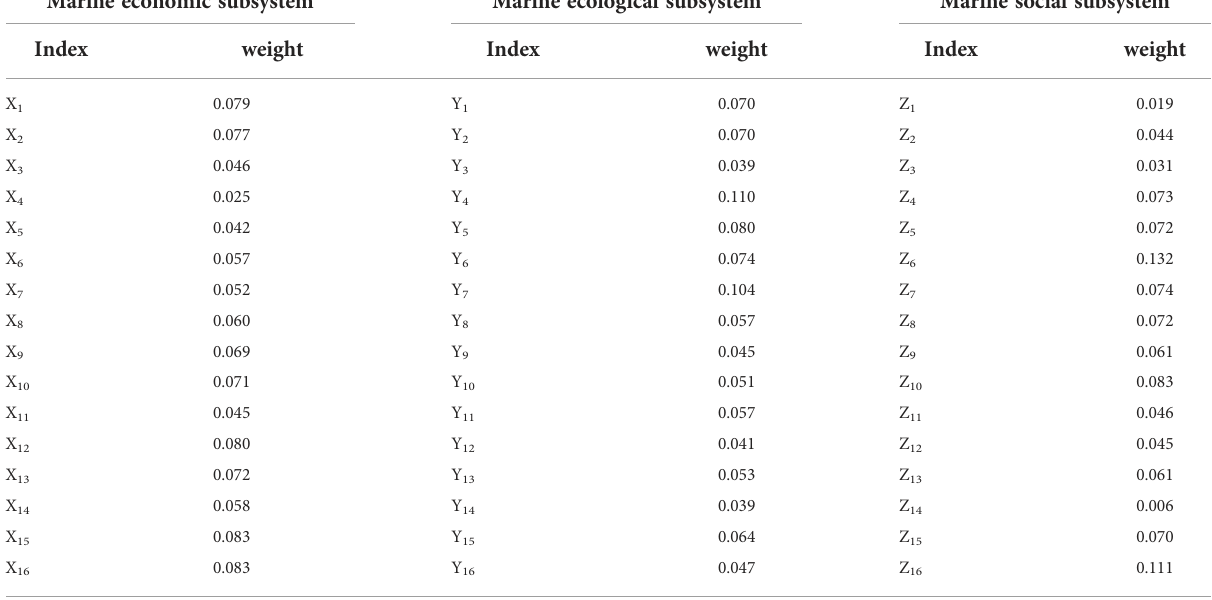
TABLE 4 Index weight of conjugate degree measurement of marine composite